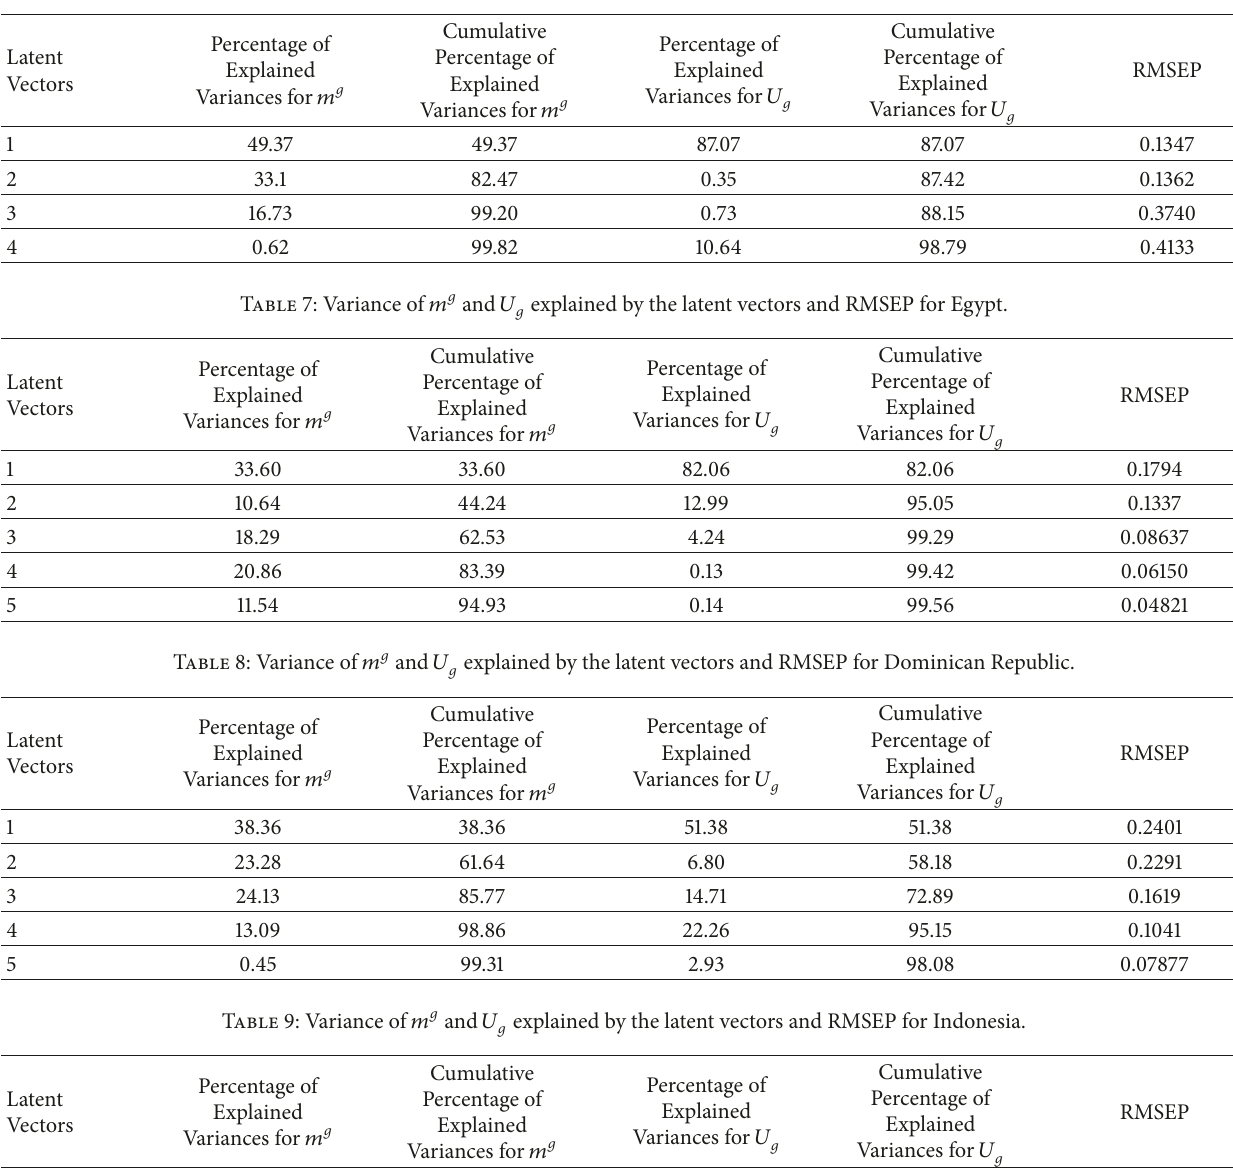
Table 6: Variance of 𝑚 𝑔 and 𝑈 𝑔 explained by the latent vectors and RMSEP for Kenya. Latent